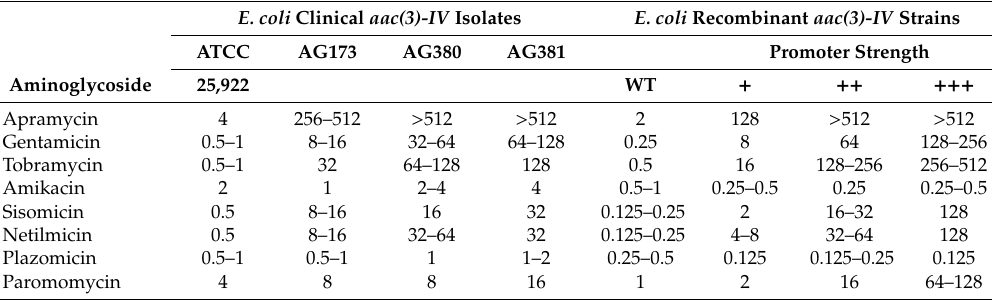
Table 1. Aminoglycoside susceptibility of E. coli aac(3)-IV